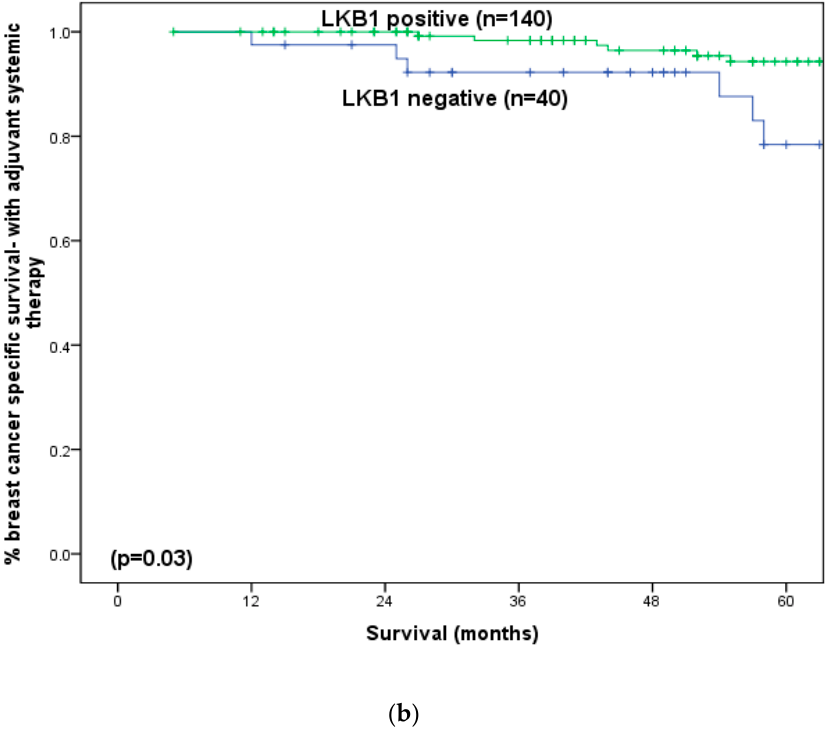
Figure 3. ( a ) Breast cancer specific survival according to the expression of LKB1 in older women with early operable primary breast cancer (all patients). ( b ) Breast cancer specific survival according to the expression of LKB1 in older women with early operable primary breast cancer who received adjuvant endocrine therapy.